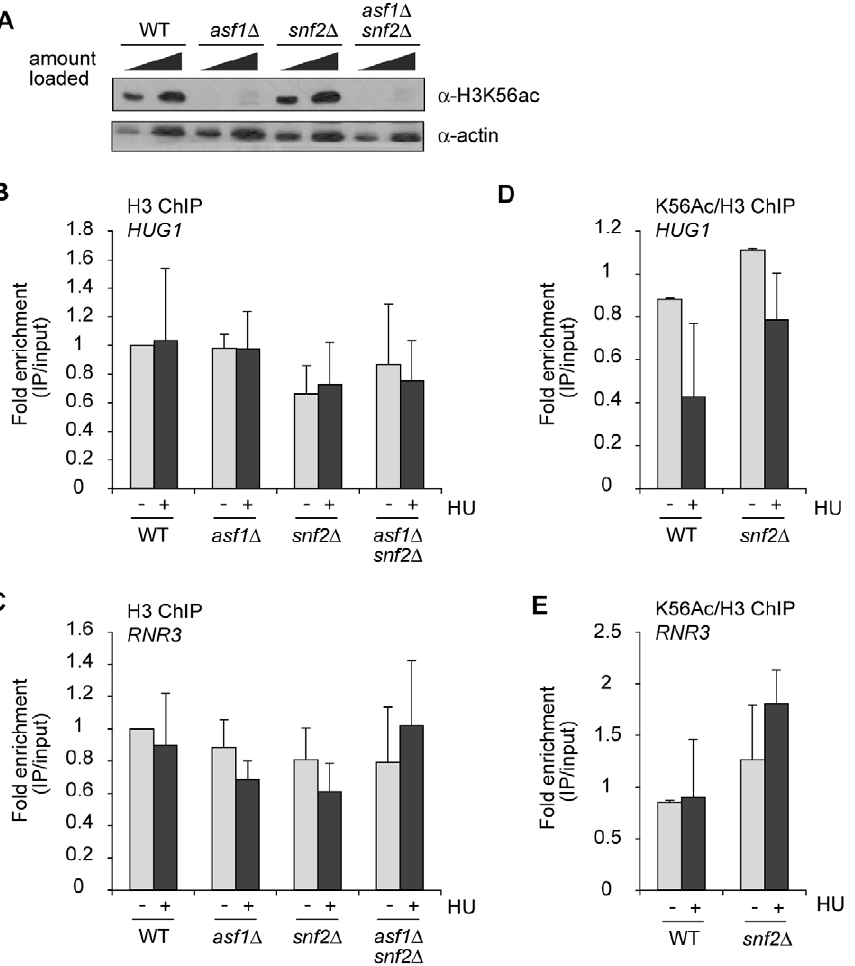
Figure 3. Regulation of H3K56ac is similar in wild type and snf2 D cells. A. Bulk expression of H3K56ac analyzed by immunoblotting. Actin is the loading control. B, C. ChIP analysis of H3 occupancy at DDR gene promoters in response to HU (one hour). Immunoprecipitated DNA was normalised to input DNA and signal obtained in untreated wild type cells was set to 1. D, E. ChIP analysis of H3K56ac occupancy at DDR gene promoters in the indicated strains grown as in B and C. Normalization of the data is described in the methods section. In B-E, error bars show standard deviation between three biological replicates.